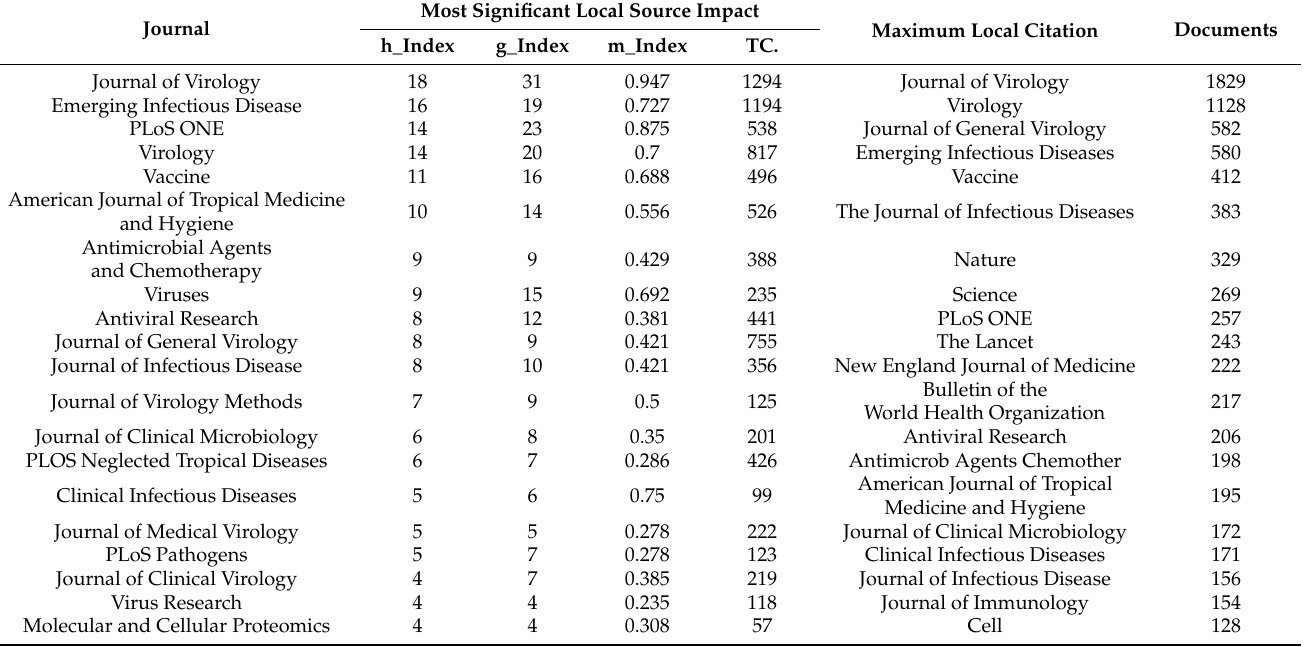
Table 2. Top 20 local sources with the most local